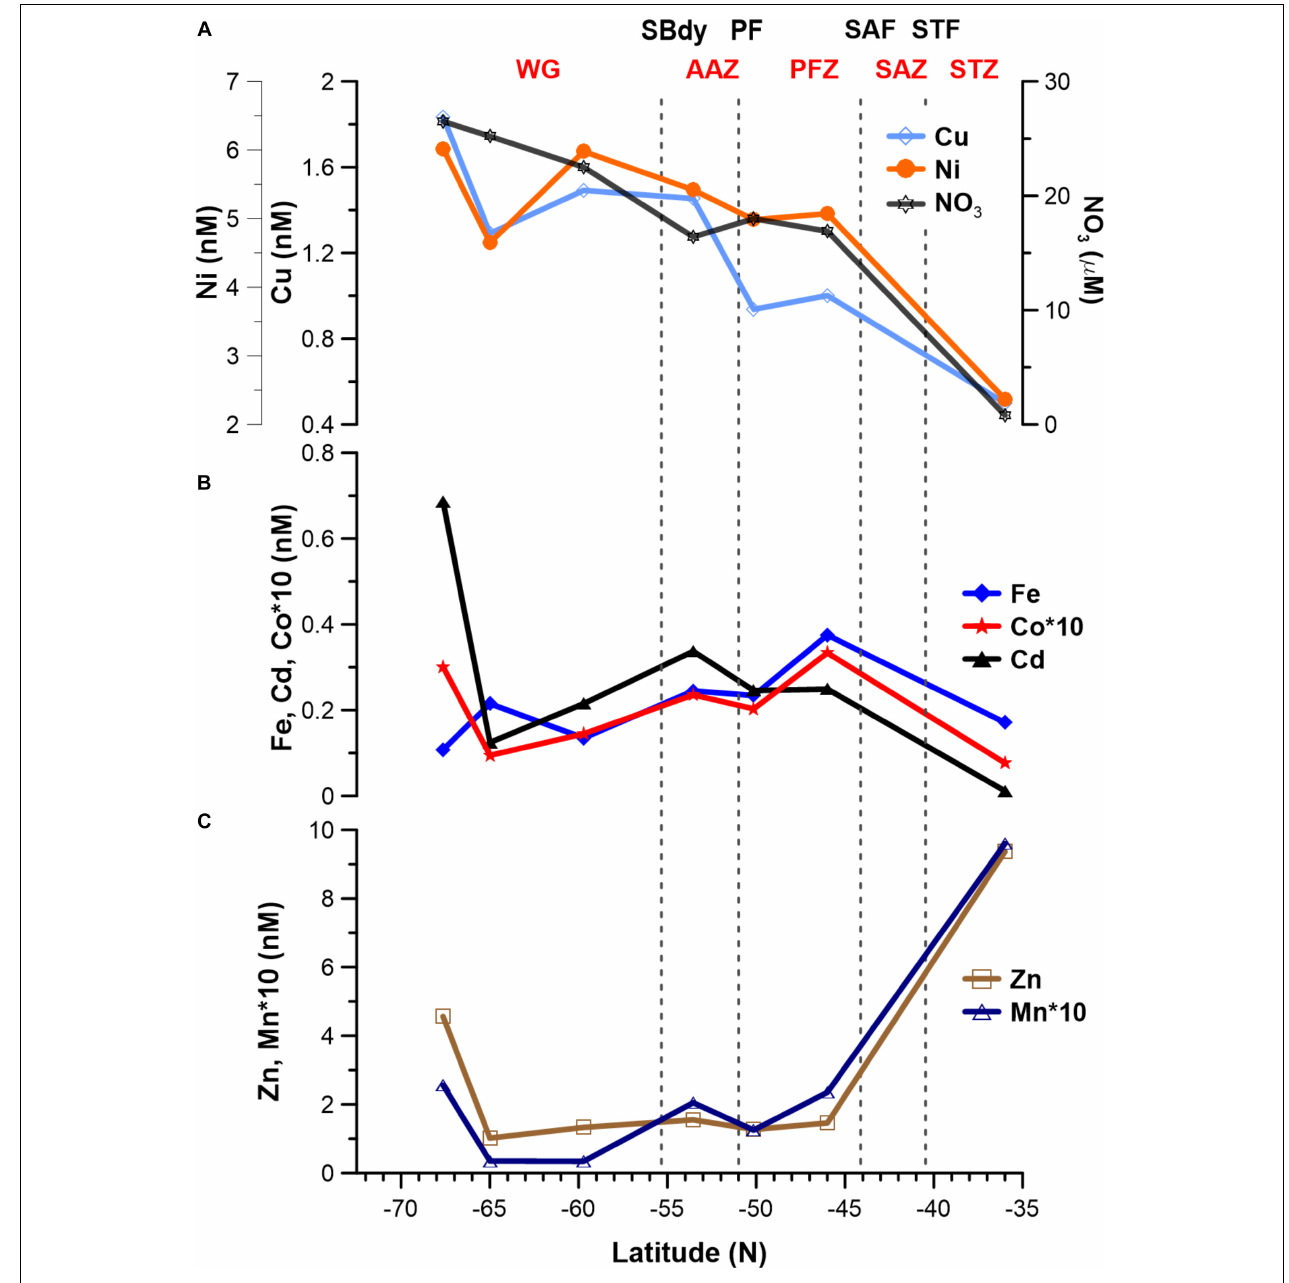
FIGURE 4 | Surface dissolved trace metal distribution for seven stations along the cruise transect ( Figure 1 ). (A) Cu ( ∗ 10) and Ni; note that nitrate concentrations are shown in (A) to illustrate the similar trends of some trace metals. (B) Fe, Co ( ∗ 10) and Cd. (C) Zn and Mn ( ∗